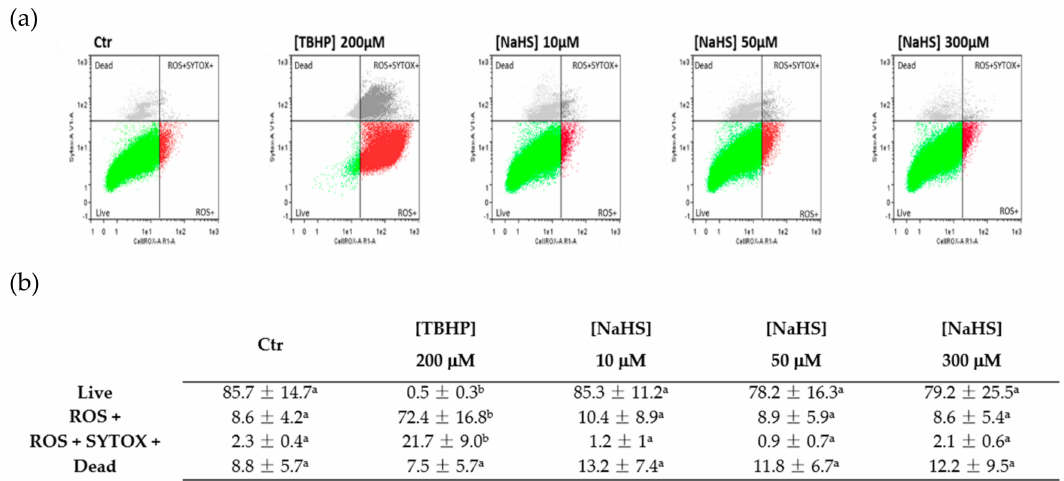
Figure 3. Representative graphs of reactive oxygen species (ROS) evaluation by flow cytometry in the pVW–MSCs treated with increasing doses of NaHS (0, 10, 50, 300 µ M) after 24 h (CTR = DMSO 0.01% v / v ) ( a ); green: live cells, red: ROS + cells, light grey: dead cells and dark grey: ROS + SYTOX + cells. ( b ) Percentage of cells (means ± S.D) at each dose. Results are representative of three independent experiments; di ff erent superscript letters indicate significant di ff erences among groups ( p < 0.05, one-way ANOVA, post hoc Tukey comparison